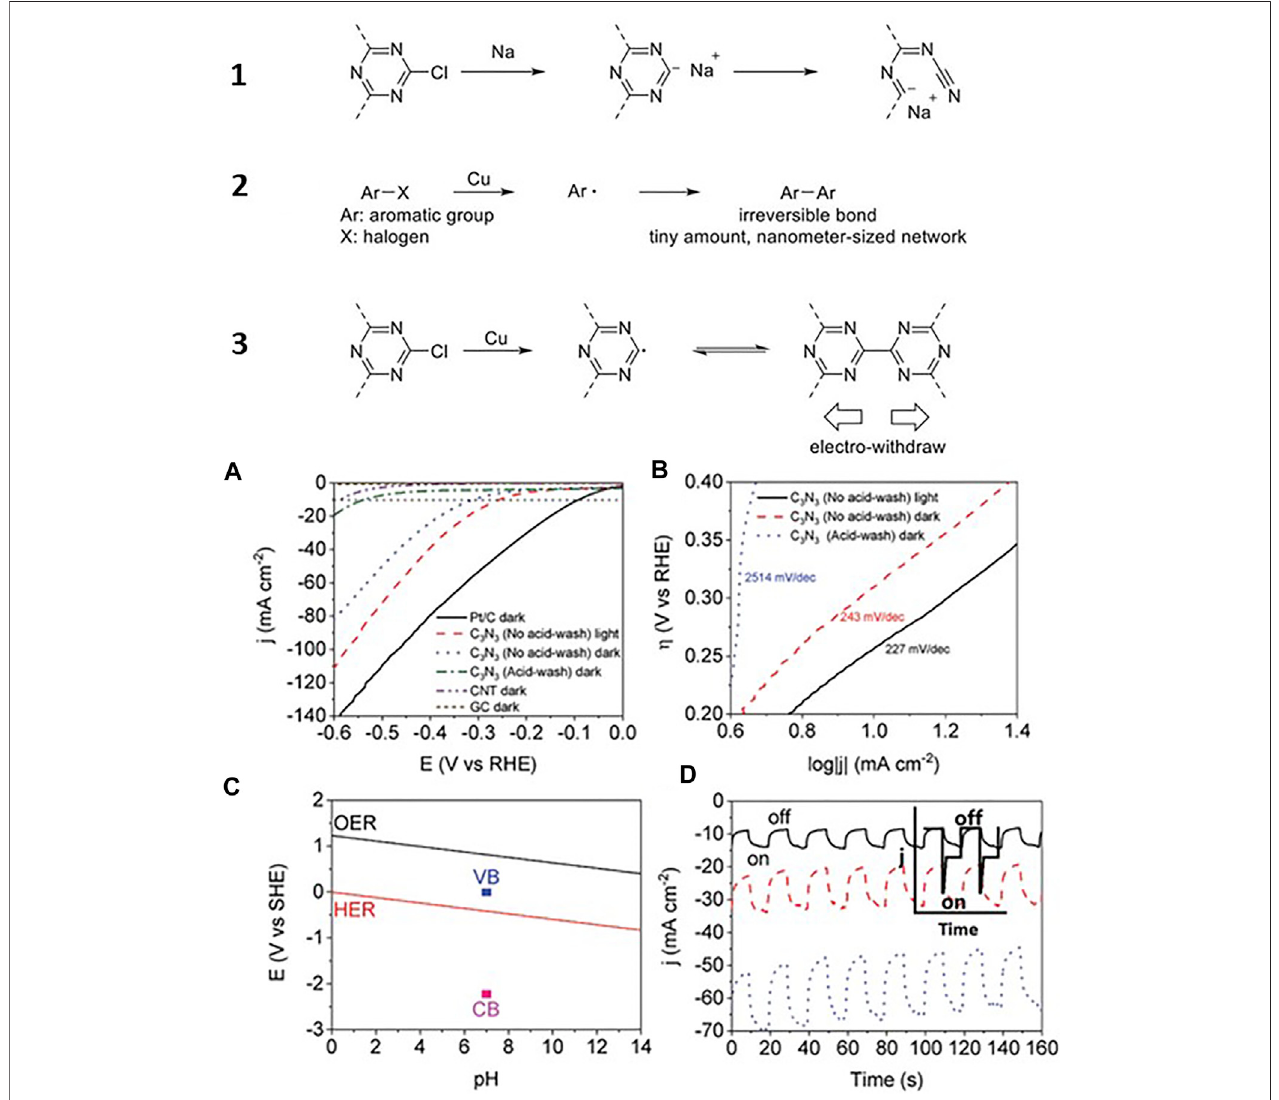
FIGURE 3 | (Top panel) Different reaction mechanisms followed to prepare C 1 N 1 materials. (bottom panel) (A) Comparing linear sweep voltammetry curves of different electrodes in dark or underlight; (B) TafelcurvesofC 3 N 3 electrodes between 0.2 and 0.4 V vs. RHE; (C) comparing red-ox coupling for water splitting, valence band (VB), and conduction band (CB) ofC 3 N 3 beforeacid wash (OER: oxygen evolutionreaction); (D) Chronoamperometric dataofC 3 N 3 under chopped light[from top to bottom: − 0.28, − 0.38, and − 0.48 V vs. RHE; the inset shows the recombination of photoelectrons and holes for reported catalysts (25)]. Reproduced with permission from Feng and Li